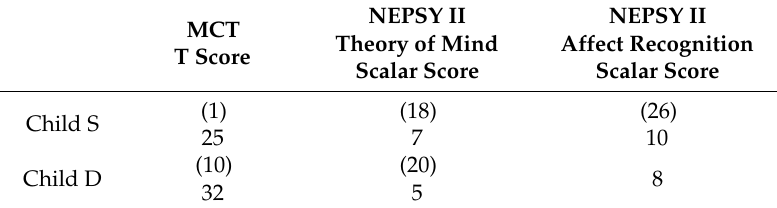
Table 1. Raw scores, T scores (Metaphor Comprehension Test: MCT) and scalar scores (NEPSY II).